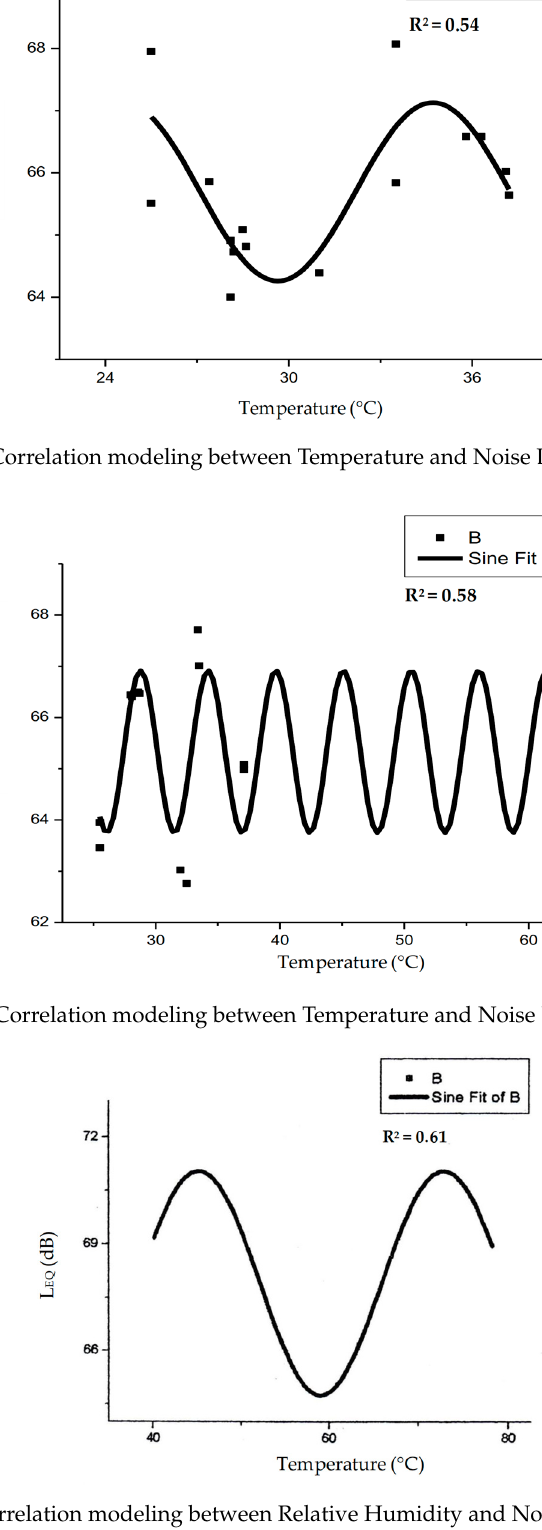
Table 14. Correlation modeling between Relative Humidity and Noise Level at O S-L Figure 11. Correlation modeling between Relative Humidity and Noise Level at Figure 11. Correlation modeling between Relative Humidity and Noise Level at OS-L.